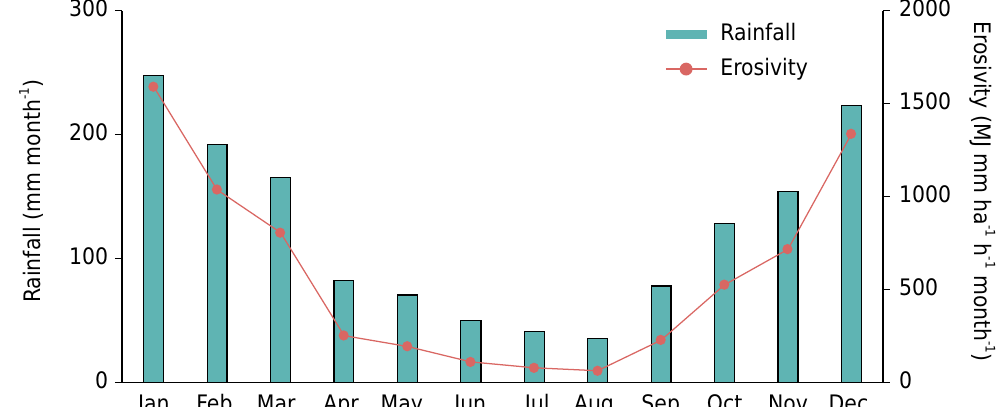
Figure 2. Monthly means of rainfall and erosivity data from 1970 to 2010 for the 66 rain gauge stations used in regression